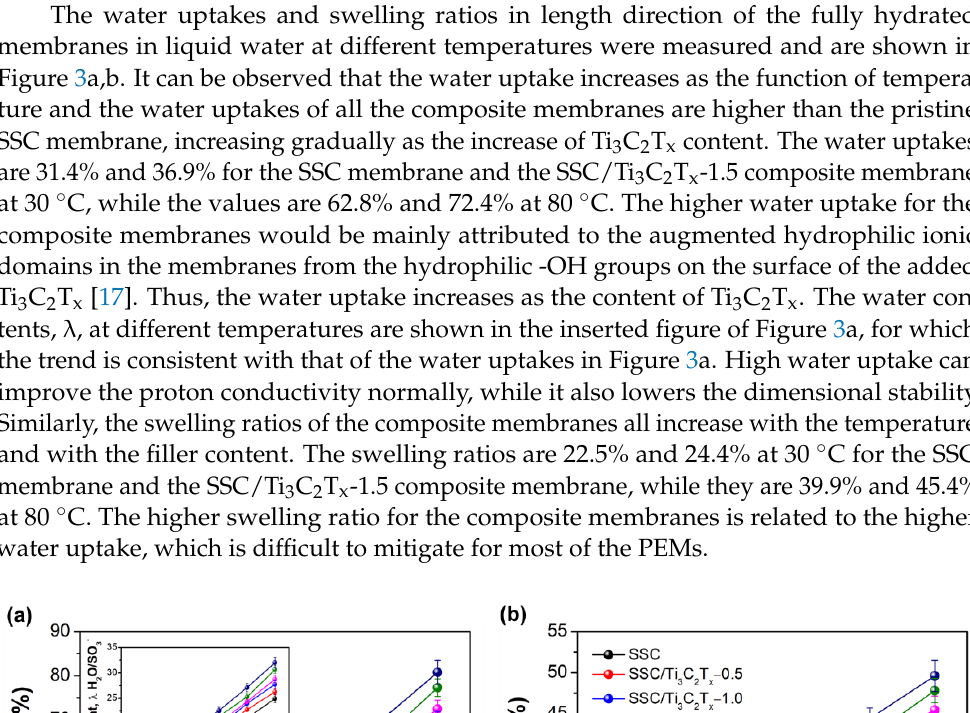
Figure 2. ( a ) Proton conductivity of short side-chain (SSC)/Ti 3 C 2 T x composite membranes in water at 30 °C and 80 °C as a function of Ti 3 C 2 T x content; and ( b ) as a function of temperature; ( c ) Arrhe- nius plots of proton conductivities.